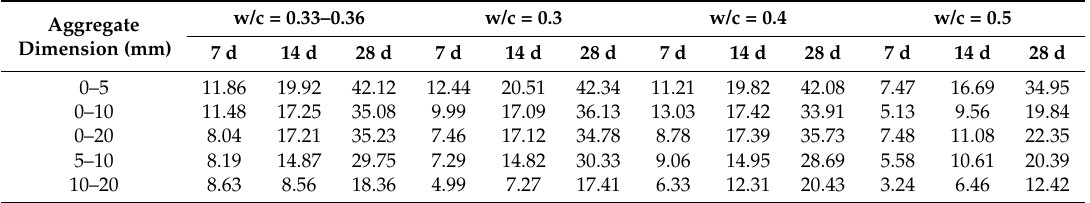
Table 2. Compressive strength of concrete in different water to cement ratio and curing days (unit: MPa) [37]. w/c = 0.33–0.36 w/c = 0.3 w/c = 0.4 Aggregate Dimension (mm)